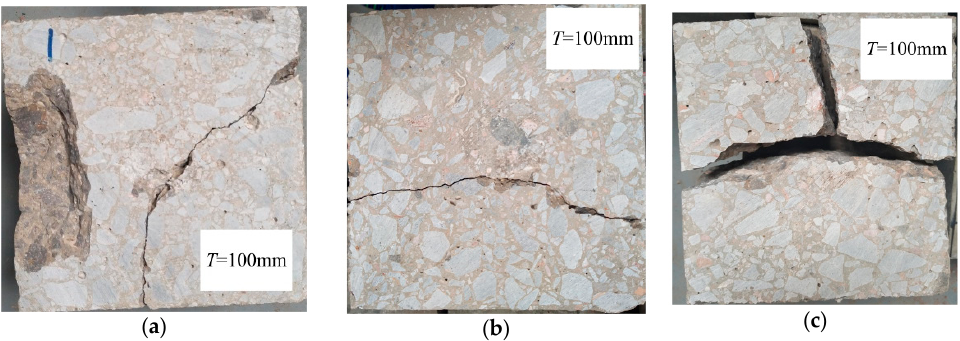
Figure 18. Failure modes. ( a ) Corner cracking with spalling; ( b ) Trans-cracking; ( c ) Fractured spec- imen.